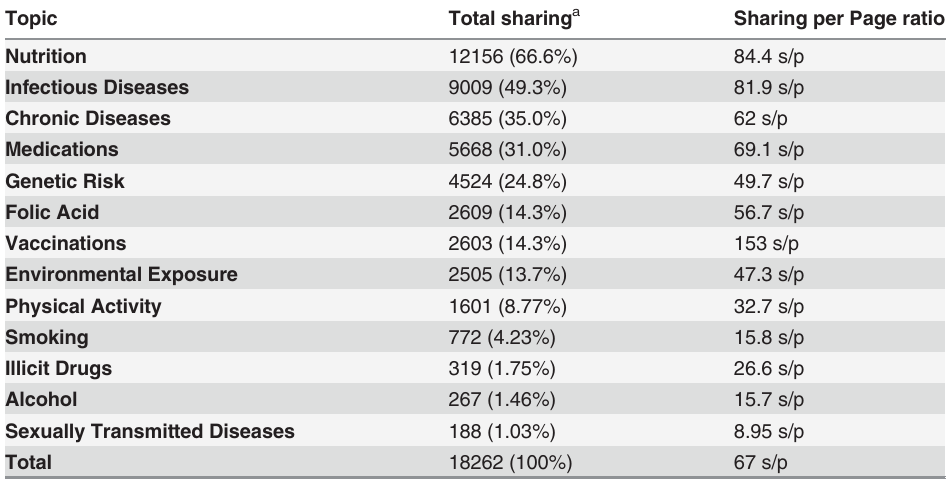
Table 3. Sharing volumes and the sharing per page (s/p) ratio for each